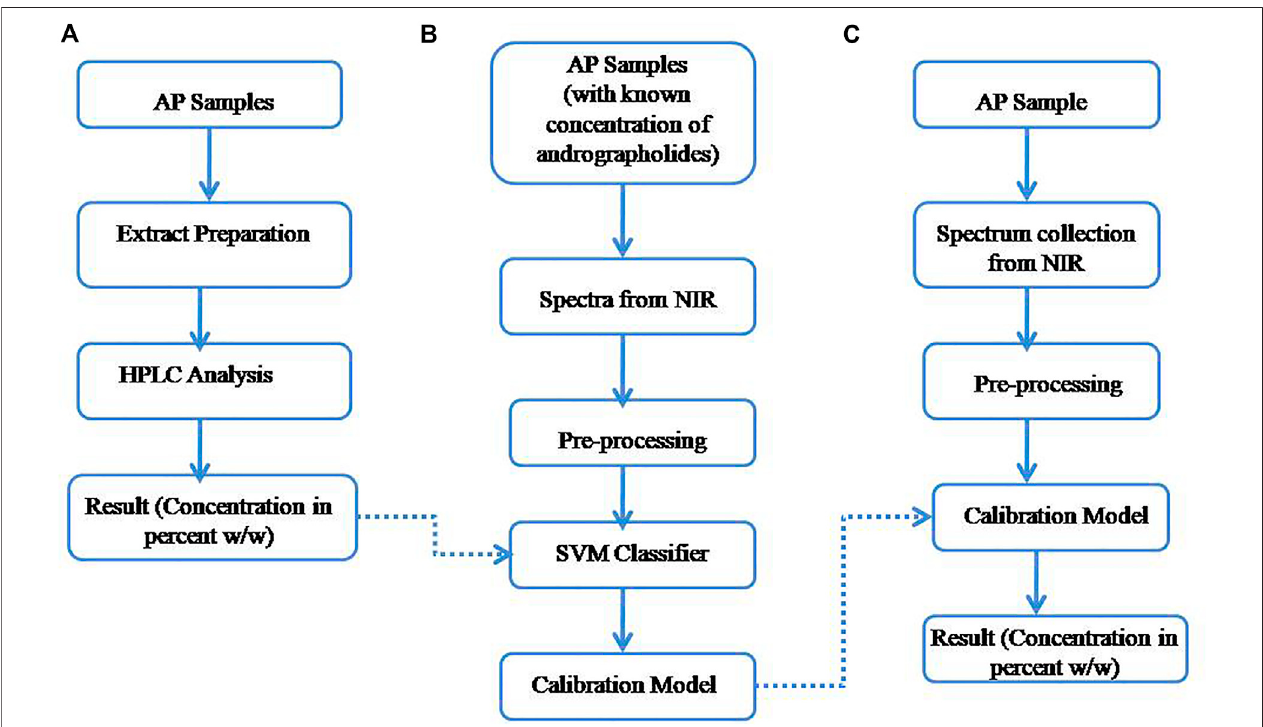
FIGURE 2 | Experimental work fl ow of (A) chemical analysis (B) training, (C) testing.